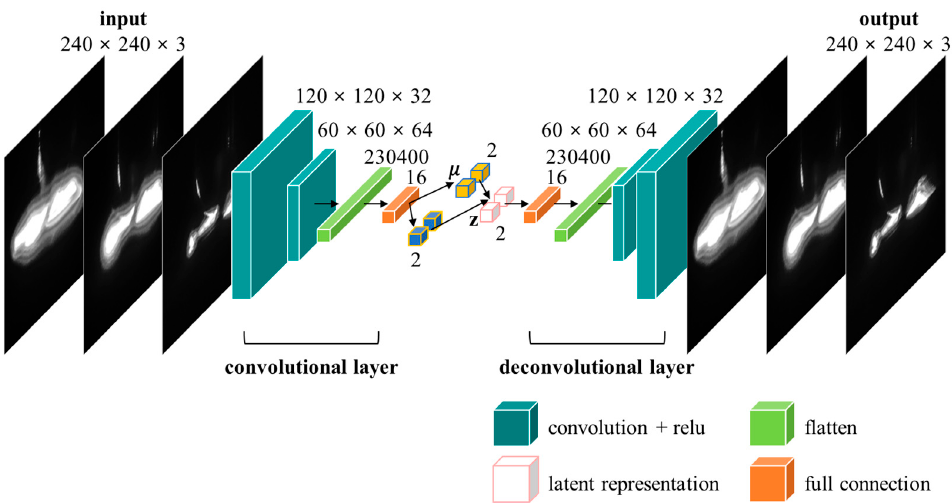
Figure 7. Variational autoencoder with convolutional layer